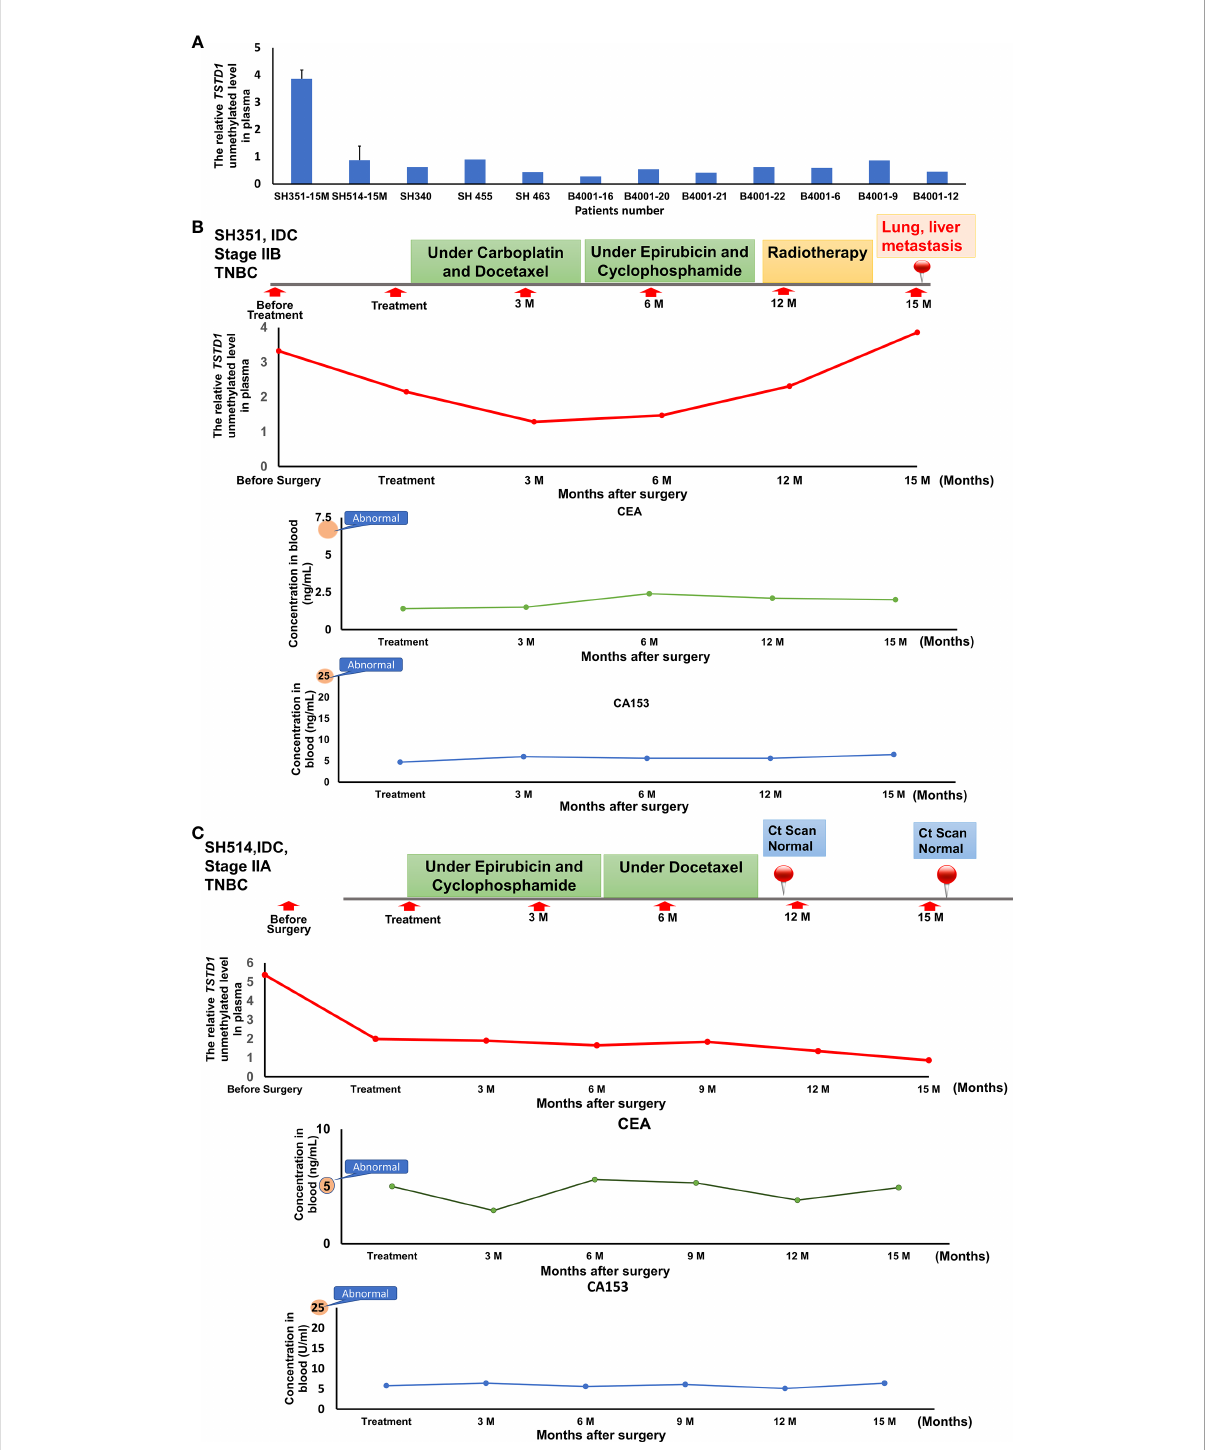
FIGURE 6 The circulating hypomethylated TSTD1 was monitored in breast cancer patients. (A) The circulating cell-free hypomethylated TSTD1 can be detected in plasma of Taiwanese breast cancer patients. (B) Distance metastasis was found in triple-negative breast cancer patients after circulating hypomethylated TSTD1 was gradually increased and revealed poor chemotherapy ef fi cacy. The concentrations of CEA and CA15-3 in serum remained normal. (C) The lower level of circulating hypomethylated TSTD1 was found in triple-negative breast cancer patients with better pro fi cient treatment response and good